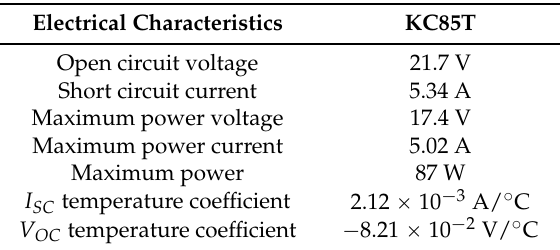
Table 1. Specifications for the KC85T PV Module.